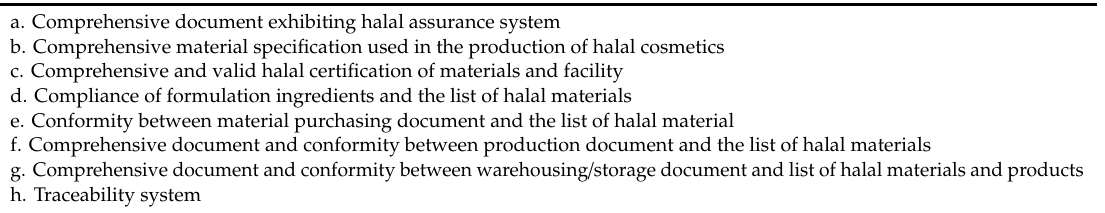
Table 5. Points for consideration in halal assurance